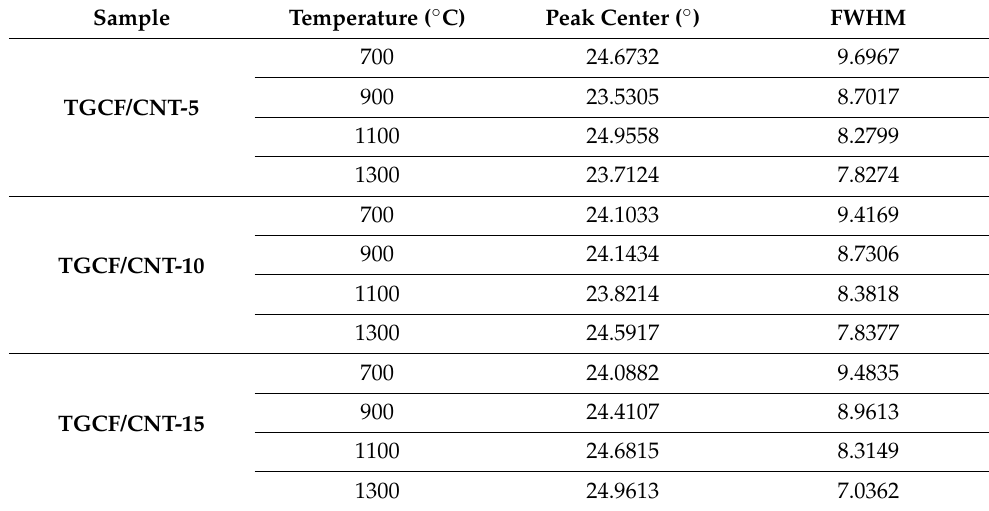
Figure 4. X-ray diffraction profiles of TGCF/CNT carbon papers for various carbonization tempera- tures and CNT contents. Table 1. X-ray diffraction data of the TGCF/CNT carbon papers obtained using various carbonization temperatures and CNT contents.